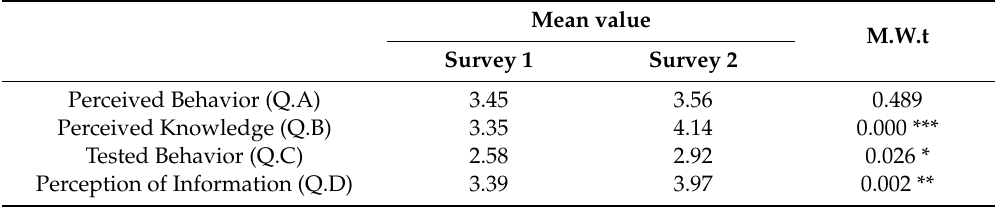
Table 3. The mean values of the answers to Questions A–D before and after the intervention. The significance of each change was calculated by Mann–Whitney tests (third